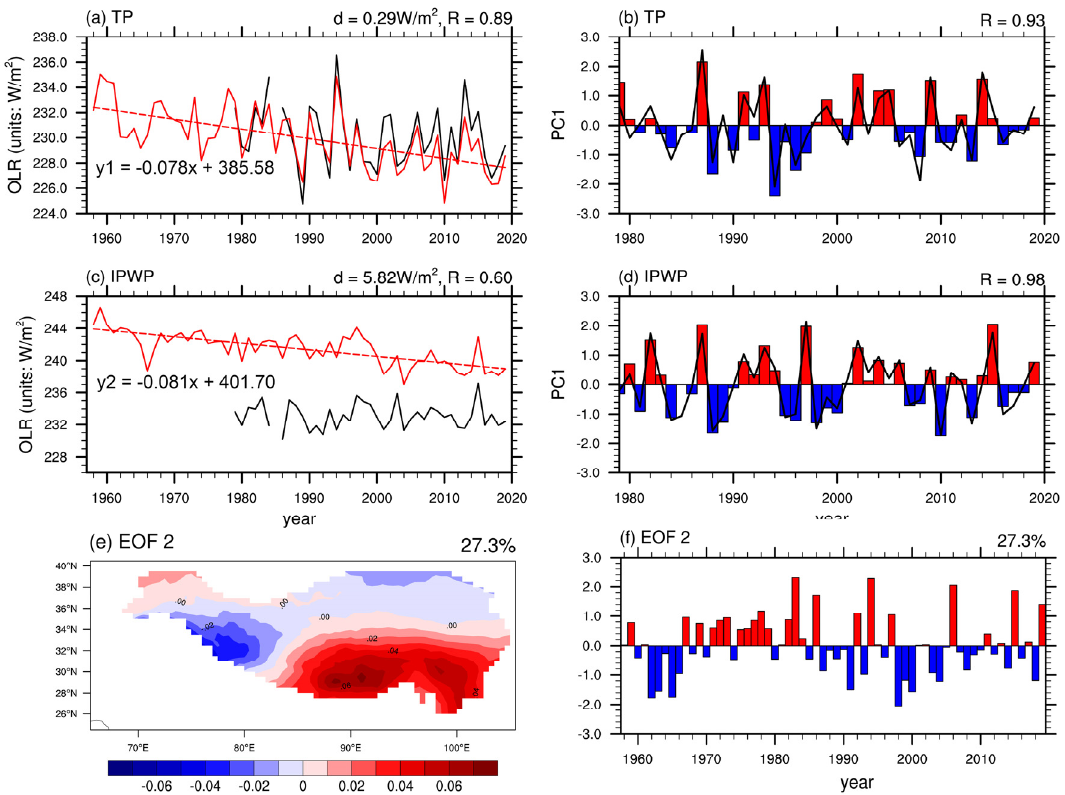
Figure 11. The climatology and trend of summer OLR over the ( a ) TP and ( c ) IPWP: the red solid and dotted lines denote the ERA5, and the black solid lines denote the HIRS OLR, respectively. The PC1 time series of EOF over the ( b ) TP and ( d ) IPWP: the bars denote the ERA5, and the black lines denote the HIRS OLR. ( e , f ) are the second mode and time series of the EOF2 for the detrended OLR over the TP.